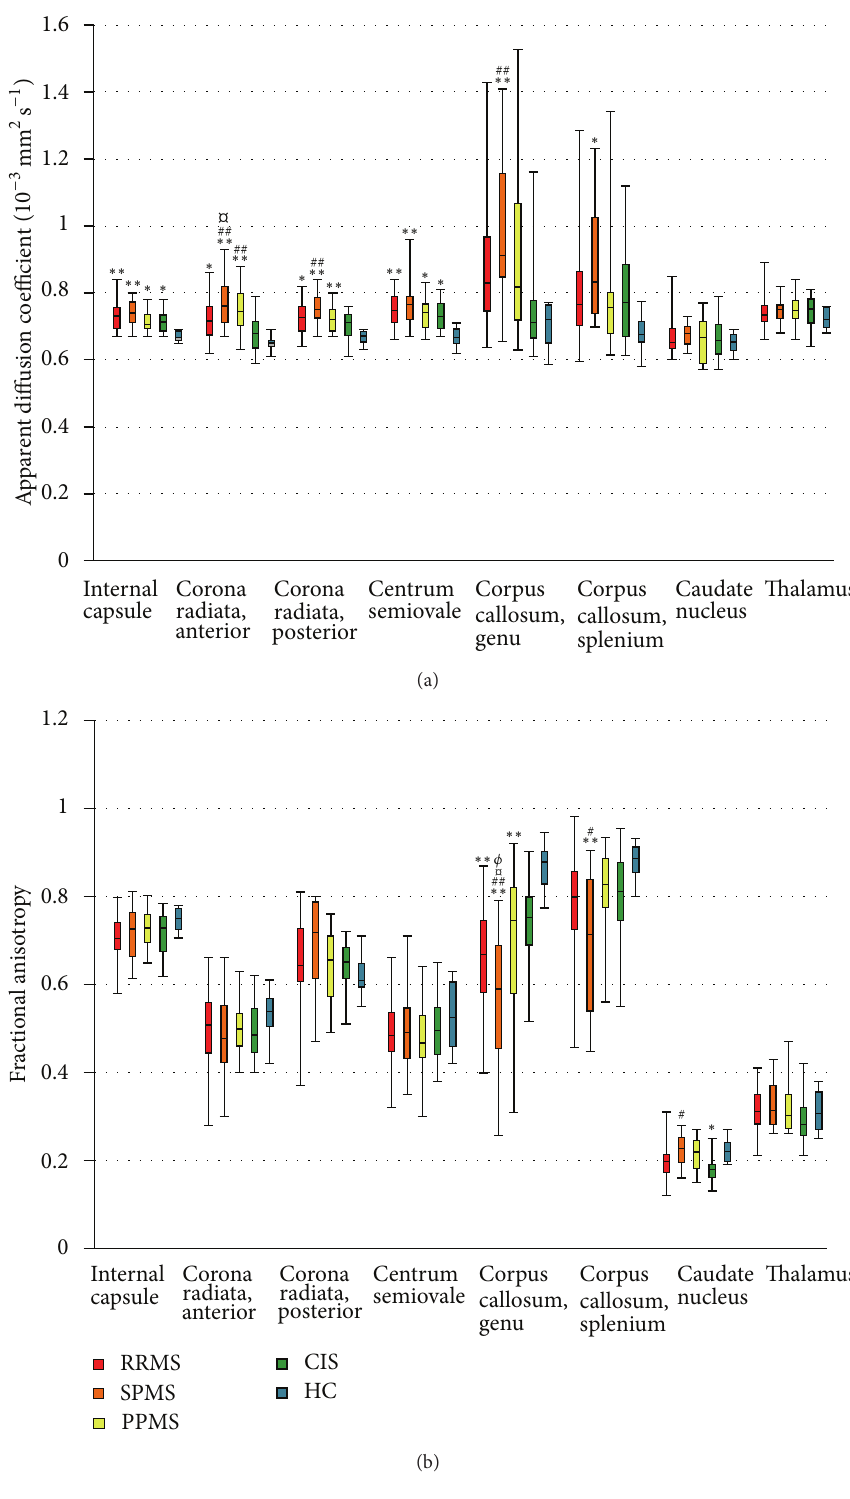
Figure 2: ADC and FA values in different brain regions of multiple sclerosis (MS) subtypes, clinically isolated syndrome (CIS), and healthy controls (HC). The length of the box represents the interquartile range, which includes the middle 50% of the values. The line through the middle of each box represents the median. The error bars show the minimum and maximum values (range). RRMS, relapsing remitting MS; SPMS, secondary progressive MS; PPMS, primary progressive MS; ADC, apparent diffusion coefficient; FA, fractional anisotropy. Reported 𝑃 values were calculated using the univariate analysis of variance with age as covariate followed by post hoc multiple pairwise comparisons with Bonferroni correction. ∗∗ 𝑃 < 0.0006 ( 𝑛 = 80), ∗ 𝑃 < 0.005 ( 𝑛 = 10 ) when compared to HC. ## 𝑃 < 0.0006 ( 𝑛 = 80), # 𝑃 < 0.005 ( 𝑛 = 10) when compared to CIS. ¤ 𝑃 < 0.005 ( 𝑛 = 80 ) in comparison to RRMS. 0 𝑃 < 0.005 ( 𝑛 = 80 ) in comparison to